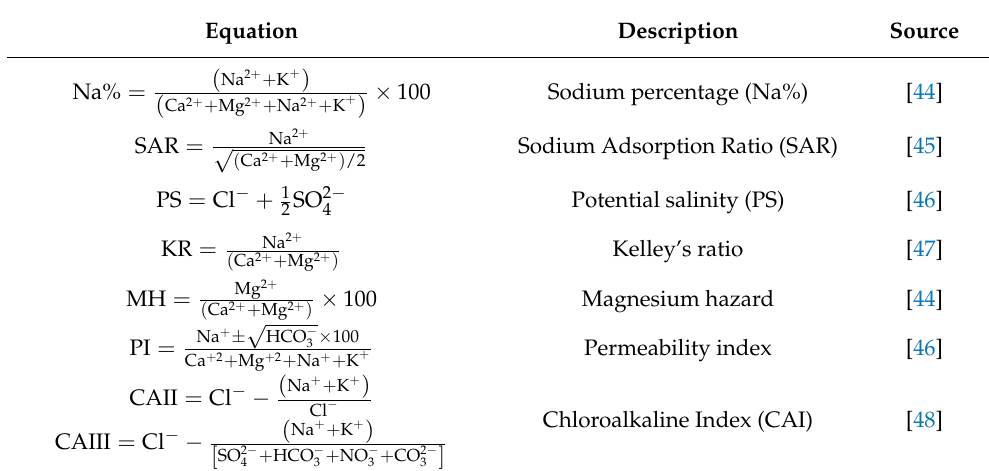
Table 1. Different water quality indices (WQIs) formulas were used in this